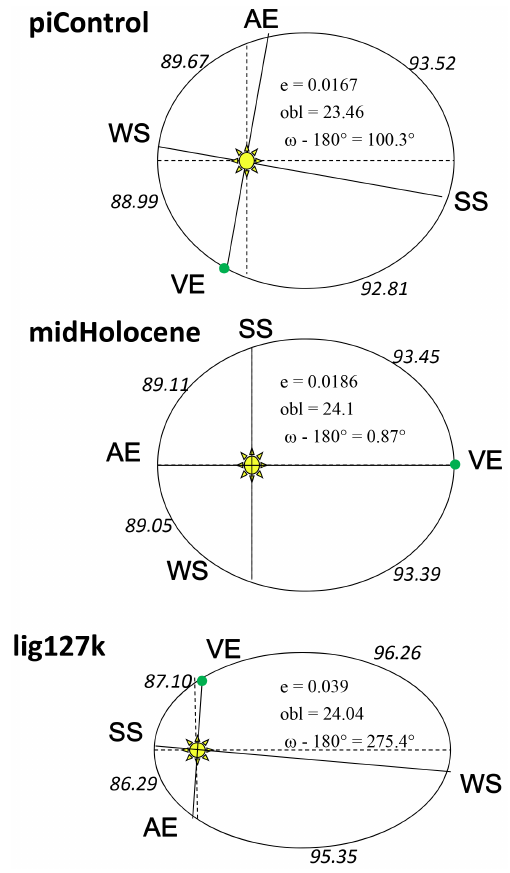
Figure 2. Orbital configurations for the piControl, midHolocene , and lig127k experiments. Note that the aspect ratio between the two axes of the ellipse has been magnified to better highlight the differences between the periods. However, the change in ratio be- tween the different periods is proportional to the real values. In these graphs VE stands for vernal equinox, SS for summer solstice, AE for autumnal equinox, and WS for winter solstice. The num- bers along the ellipse are the number of days between solstices and